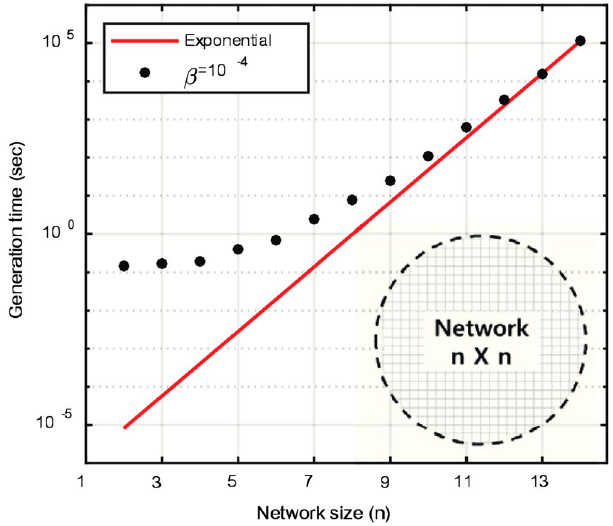
Figure 9. Time spent for generating one drainage network with a size of n using Gibbs’ model with β = 10 − 4 . It took more than 10 min to generate one drainage network with the network size, n = 11 , used in this